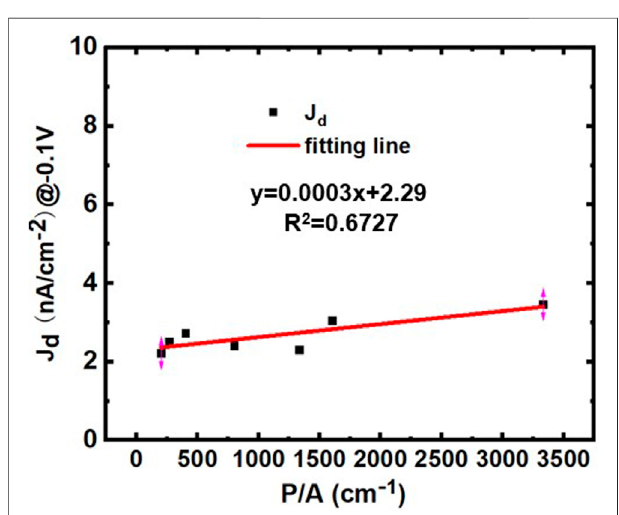
FIGURE 10 | Dark current density versus